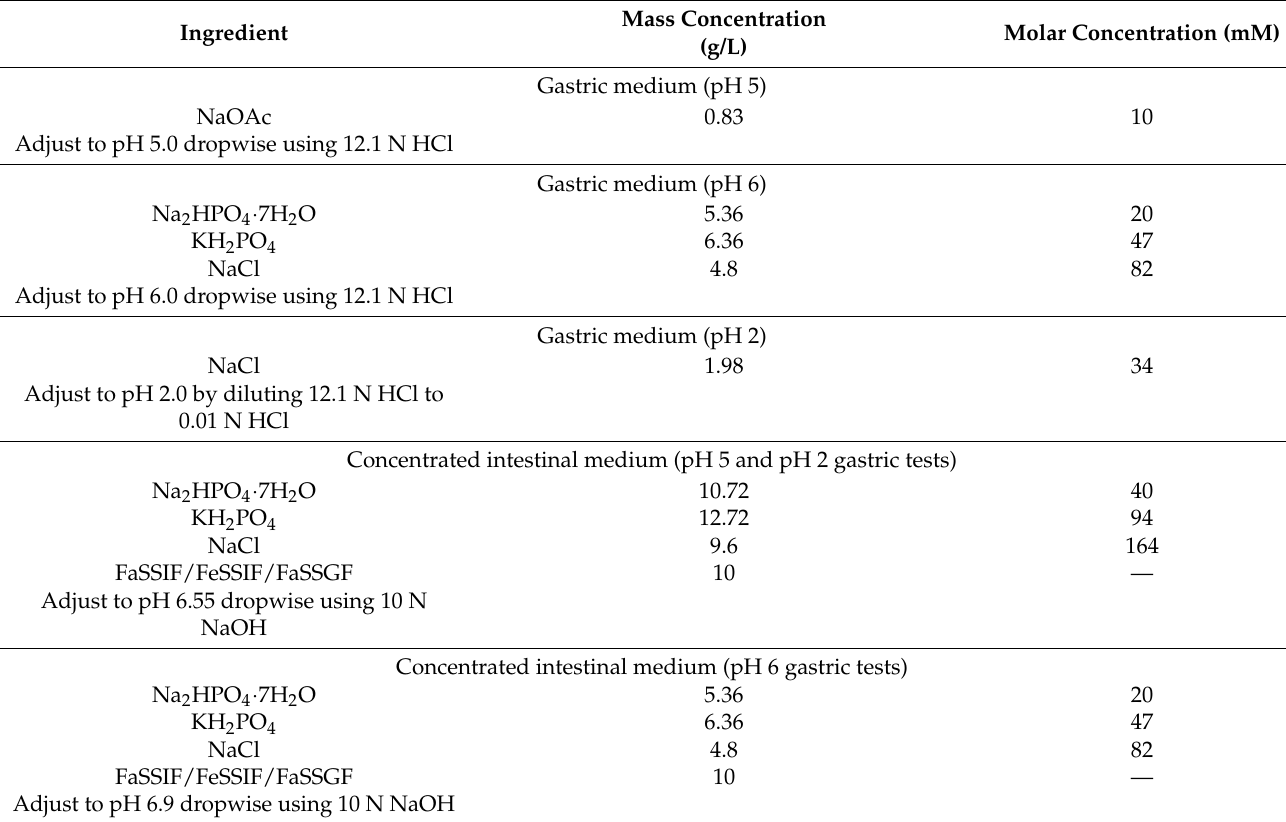
Table A1. Simulated gastric and concentrated intestinal media compositions used in Pion µ Diss dissolution testing of ASD intermediates. Ingredient